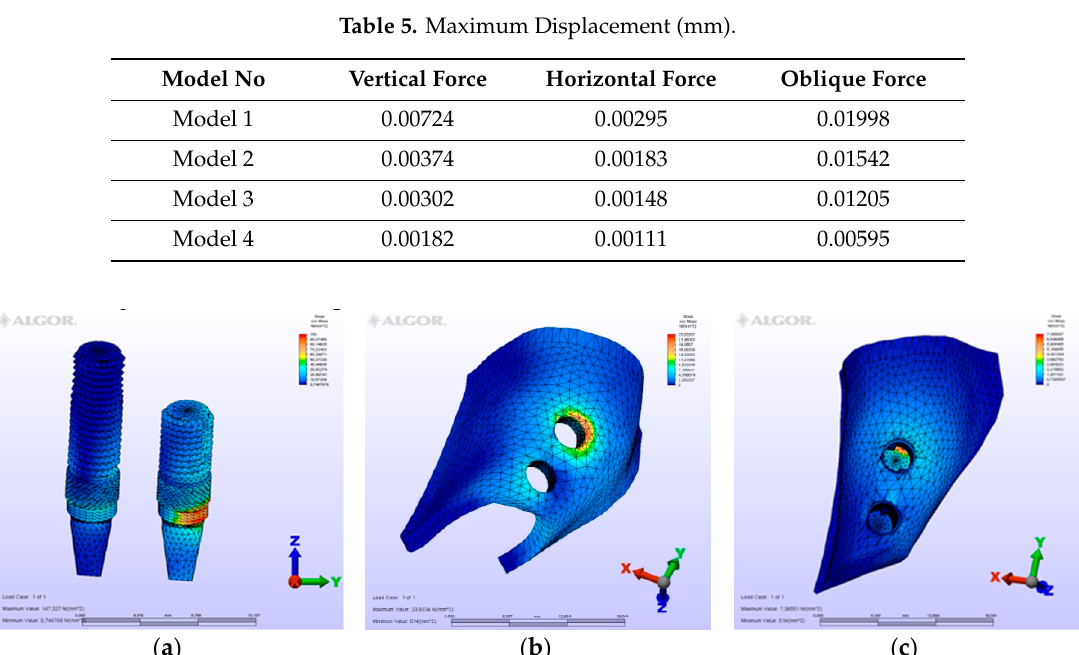
Figure 2. Model M1, axial loading. ( a ) the maximum von Mises stresses around implants; ( b ) maximum principle stress in cortical bone; ( c ) maximum principle stress in cancellous bone.